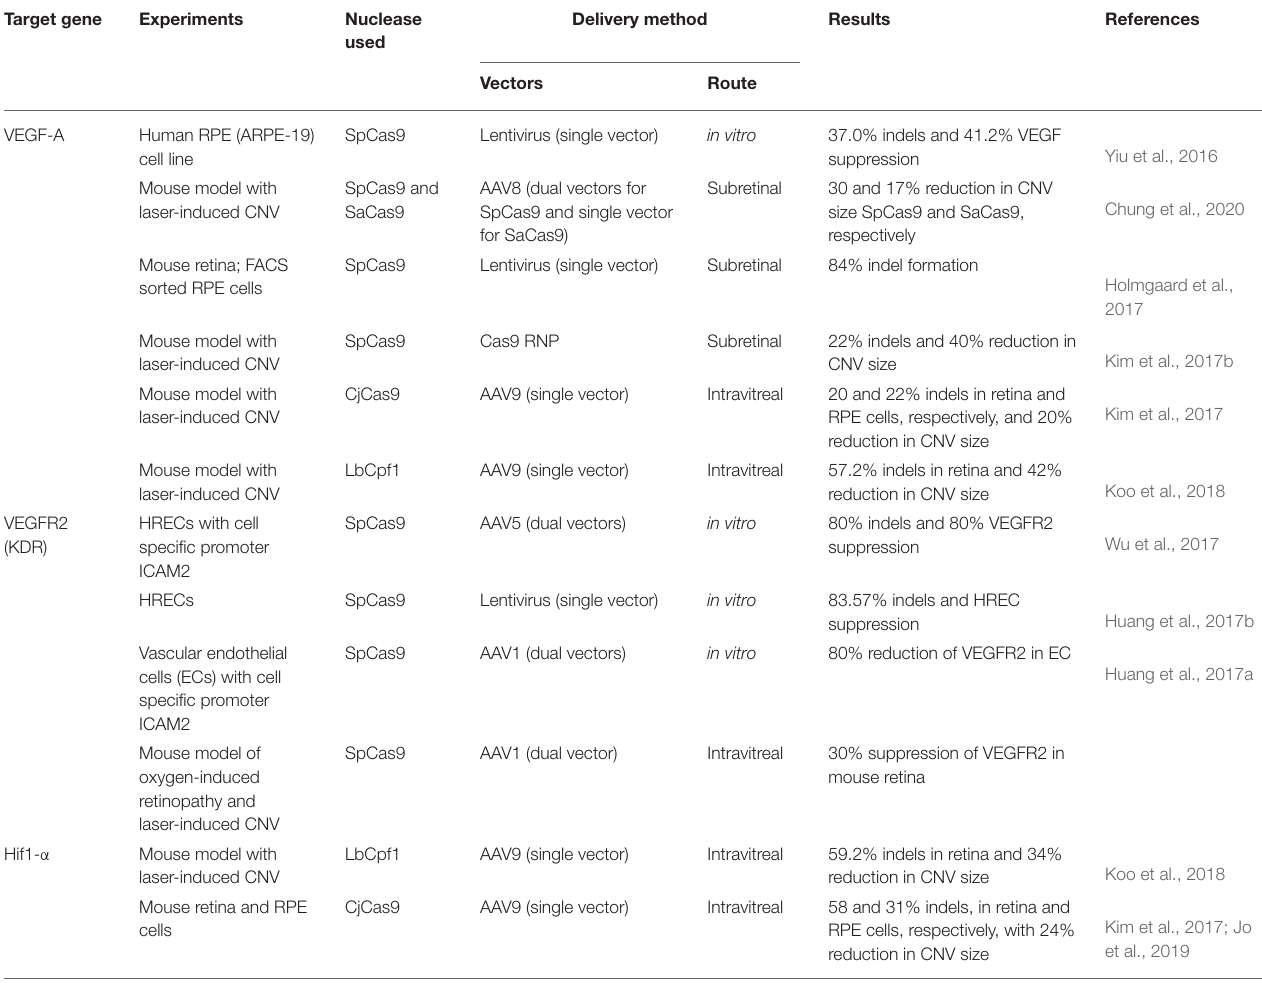
TABLE 2 | A summary of CRISPR technology suppressing pathologic ocular proangiogenic